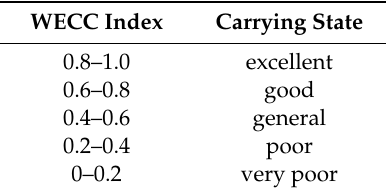
Table 4. Water environment carrying capacity (WECC) carrying state